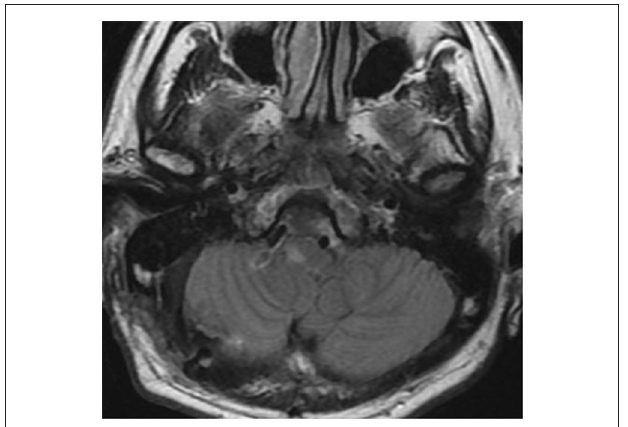
FIGURE 9 | Postoperative fluid-attenuated inversion recovery imaging of case 3 revealed a small lateral medullary infarction.